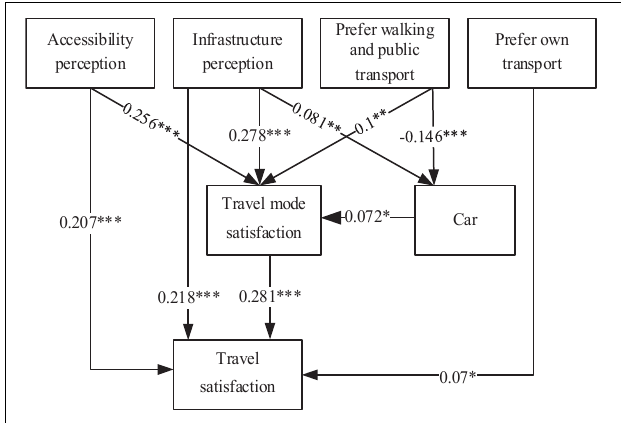
FIGURE 9 | Built environment perception and travel mode preference. ***Represents p value < 0.01, **Represents p value < 0.05, and *Represents p value < 0.1.